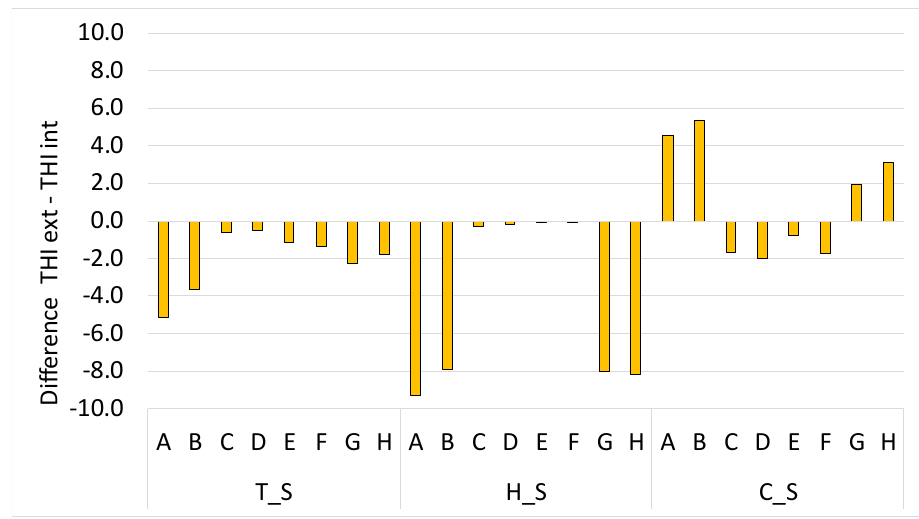
Figure 3. Average difference between the THI outside the barn (THI external) and the one inside the barn (THI internal) for every farm (A to H) and period (thermoneutral = T_S, hot = H_S and cold = C_S) of the monitoring.